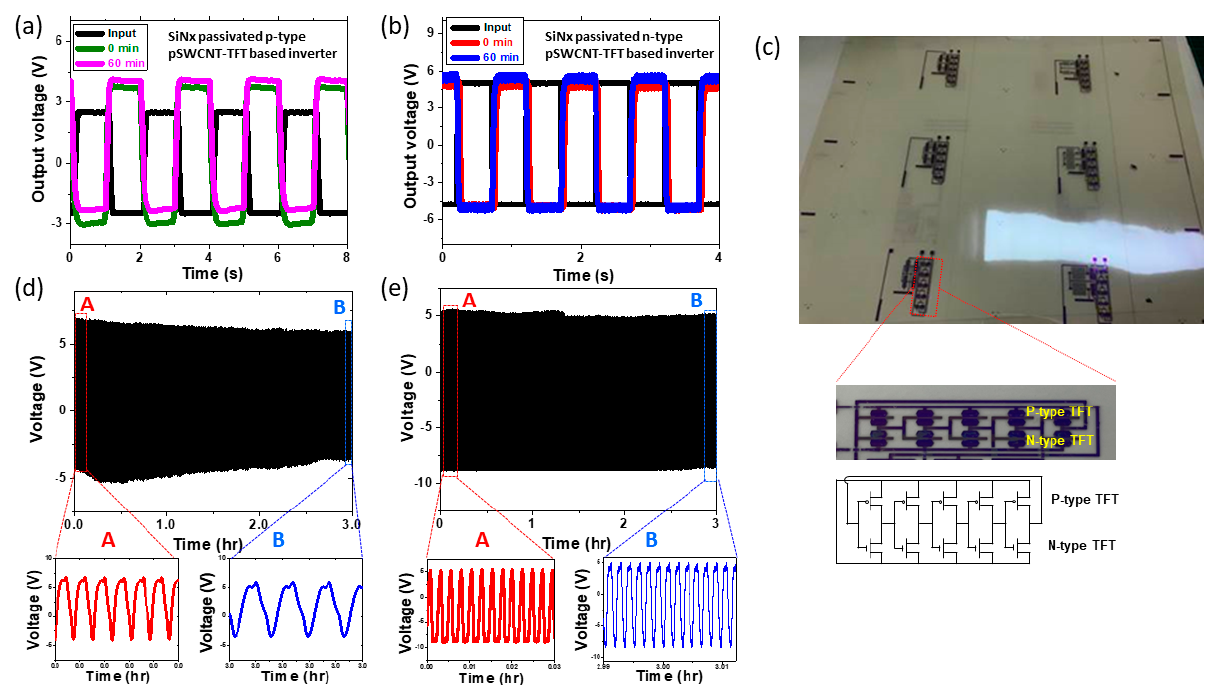
Figure 3. Stability test of pSWCNT-TFTs and 1-bit code generator. Inverting property with SiNx Figure 3 . Stability test of pSWCNT ‐ TFTs and 1 ‐ bit code generator. Inverting property with SiNx passivation layer of ( a ) p-type pSWCNT-TFT and ( b ) n-type pSWCNT-TFT along with time. ( c ) Optical passivation layer of ( a ) p ‐ type pSWCNT ‐ TFT and ( b ) n ‐ type pSWCNT ‐ TFT along with time. ( c ) Op ‐ image of the R2R-printed 1-bit code generator and their circuit design consisting of five p-type and tical image of the R2R ‐ printed 1 ‐ bit code generator and their circuit design consisting of five p ‐ type five n-type pSWCNT-TFTs. Stability of 1-bit code generator ( d ) without SiNx passivation layer and and five n ‐ type pSWCNT ‐ TFTs. Stability of 1 ‐ bit code generator ( d ) without SiNx passivation layer and ( e ) with SiNx (~200 nm) passivation layer along with time. ( e ) with SiNx (~200 nm) passivation layer along with time.